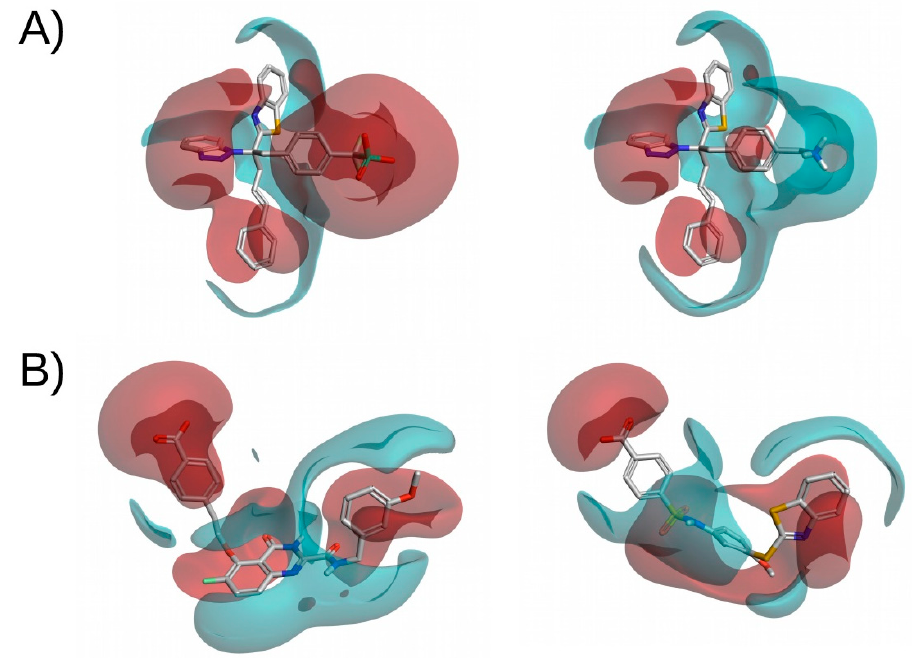
Figure 4. Electrostatic potential comparisons of two pairs of molecules. ( A ) Shows two structurally similar compounds with a different electrostatic potential. ( B ) Shows two compounds with a different molecular structure but a high electrostatic potential similarity. Red and blue surfaces correspond, respectively, to negative and positive electrostatic potentials. This figure was obtained with Flare [14].